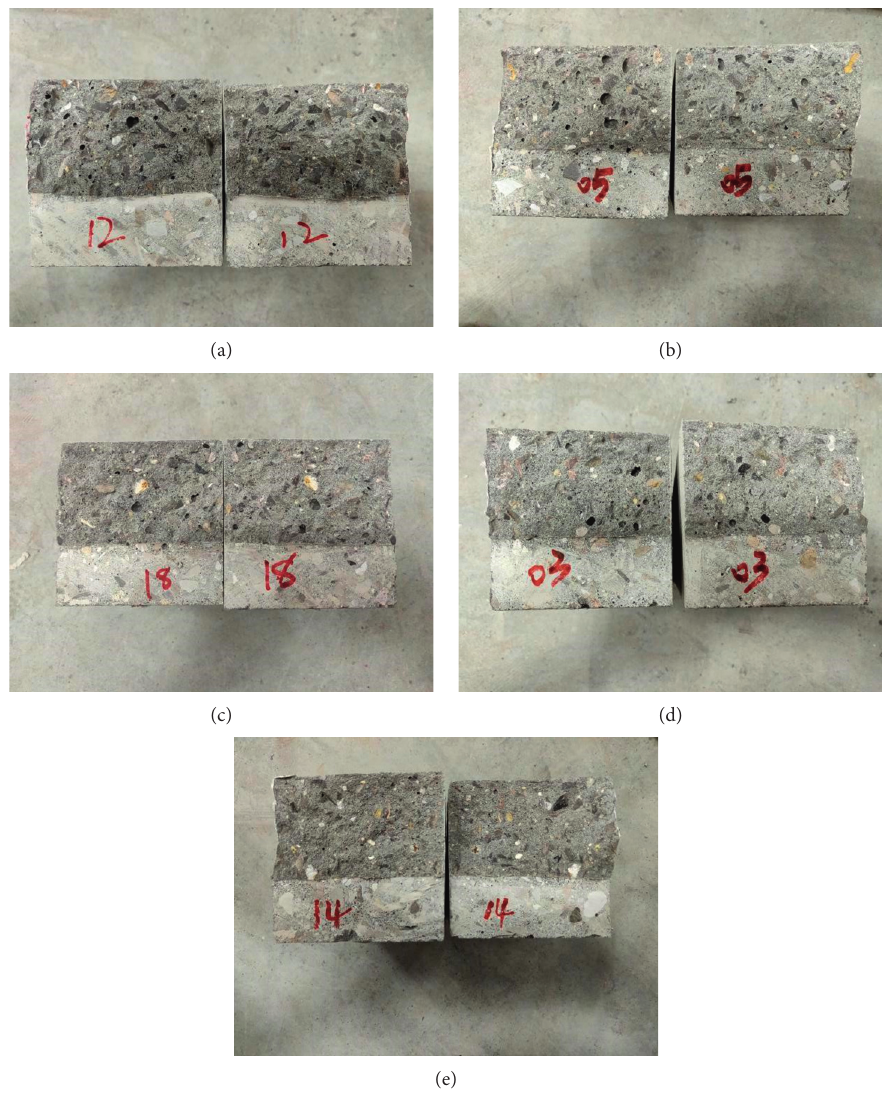
Figure 4: The fracture surfaces of concrete specimens. (a) 1mm/s. (b) 0.1mm/s. (c) 0.01mm/s. (d) 0.001mm/s. (e)